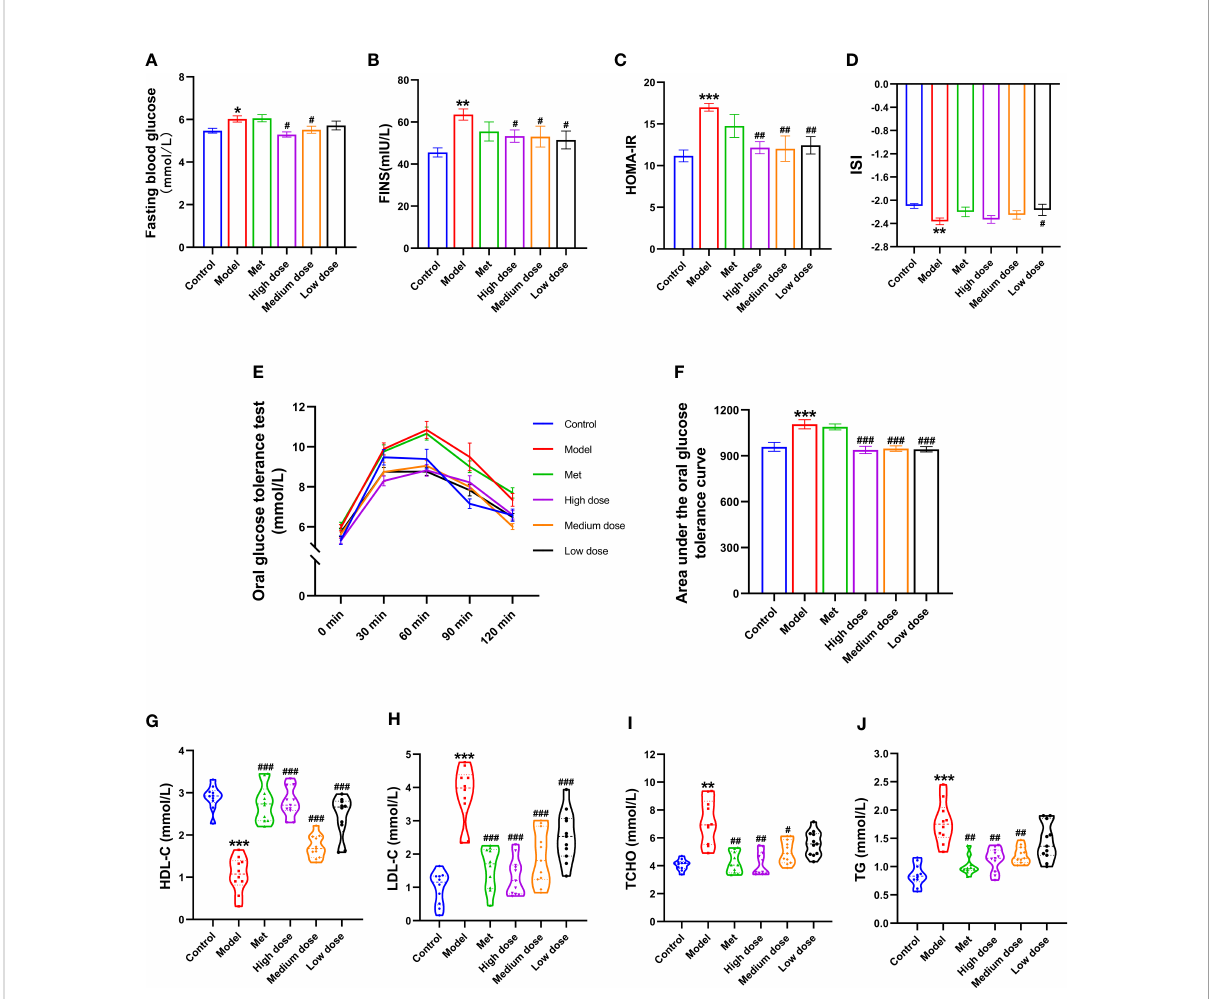
FIGURE 6 Effects of MCDD on insulin resistance in PCOS-IR rats. (A) Fasting blood glucose of rats was measured by glucose oxidase method after fasting for 12 hours, (B) FINS, (C) HOMA-IR, (D) ISI, (E, F) OGTT area under the curve, the changes of serum IR-related indexes of rats were detected by enzyme-linked immunosorbent assay kit. (G – J) four blood lipid biochemical indicator were measured by automatic biochemical analyzer. The above results are expressed as mean ± SEM, n = 8~12. *** P < 0.001, ** P < 0.01, * P < 0.05, vs. control group, ### P < 0.001, ## P < 0.01, # P < 0.05, vs. model